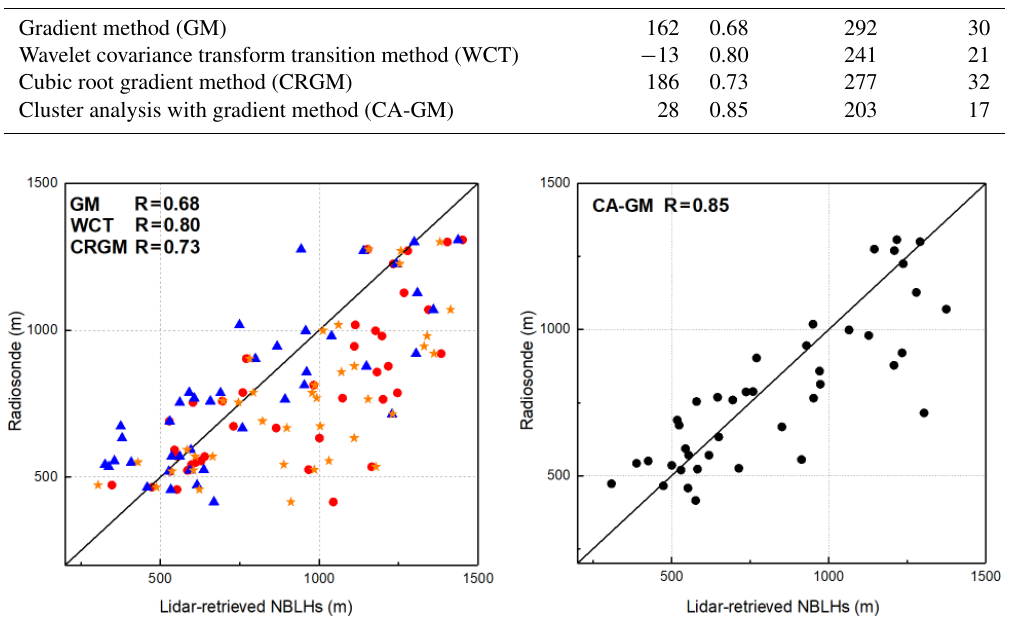
Figure 4. Comparison between the radiosonde-determined and lidar-retrieved NBLH measurements via the gradient method (GM, red circle), wavelet covariance transform transition method (WCT, blue triangle), cubic root gradient method (CRGM, orange star), and cluster analysis of gradient method (CA-GM, black circle). The correlation coefficient is represented by R . The solid black line is the 1 : 1